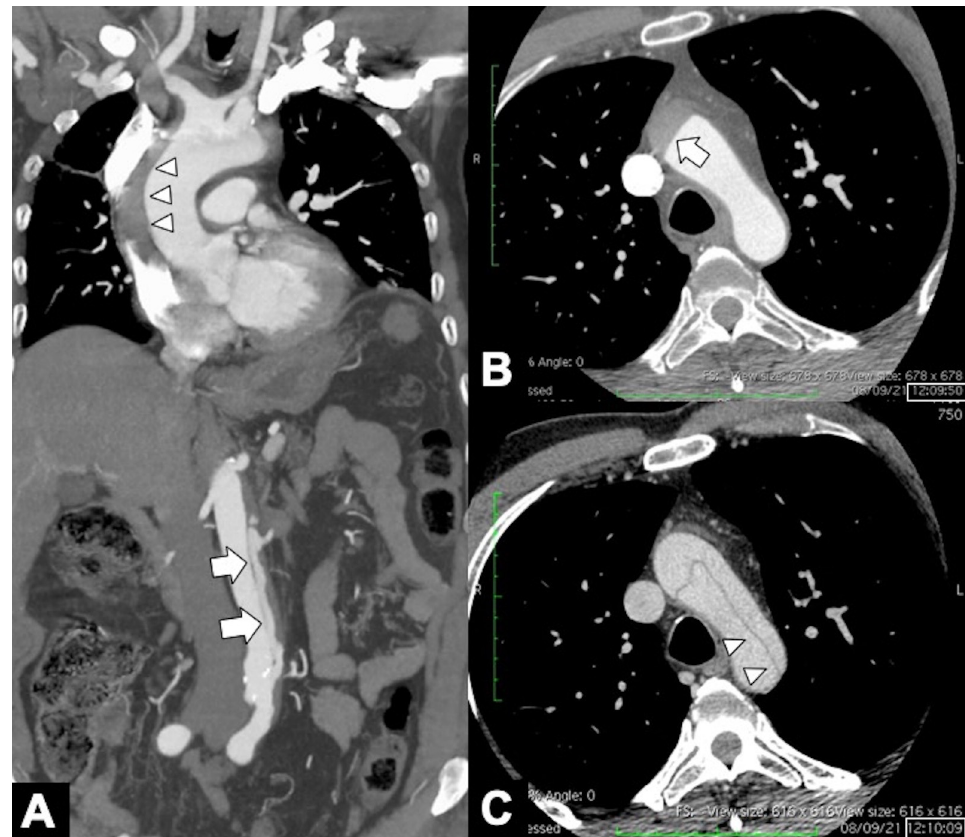
Figure 3. ( A ) Coronal MPR image of CTA in a 57-year-old man with chest pain and troponin negative shows coexistence of an acute intramural hematoma in the ascending aorta (type A IMH, arrowheads) and a dual-barrel dissection in the abdominal aorta (arrows). ( B , C ) Axial CTA images in another patient, showing the extension of the dissection flap from the proximal arch (arrow) to its distal segment (arrowheads) after only 19 s in the same CTA examination. Aortic dissection may be a very dynamic process.